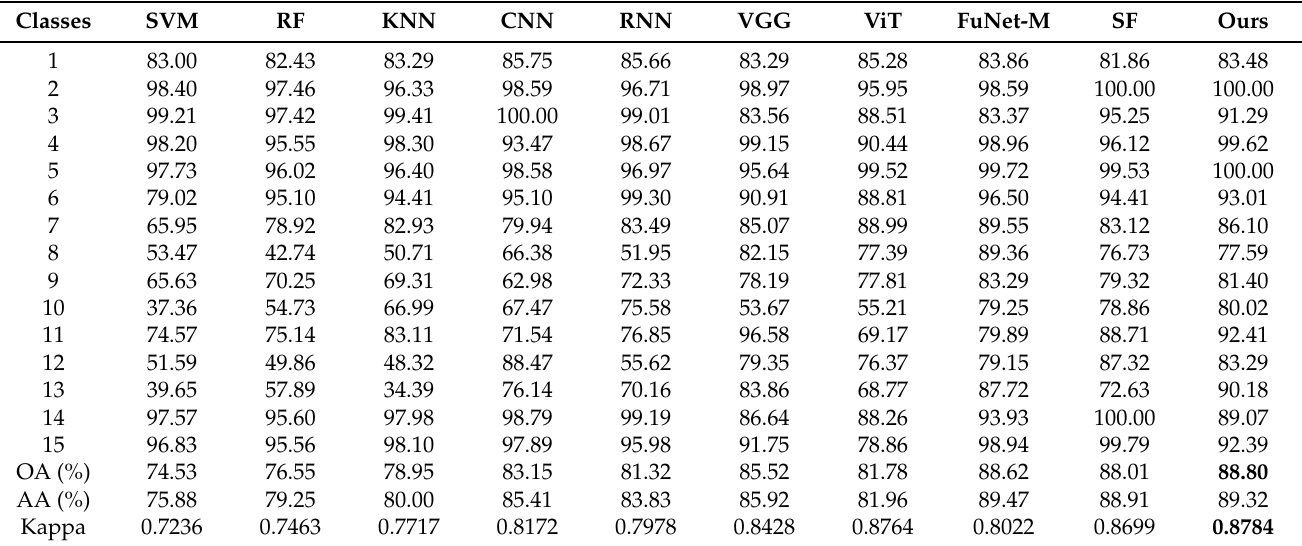
Table 8. OA, AA and kappa results of various algorithms on Houston 2013